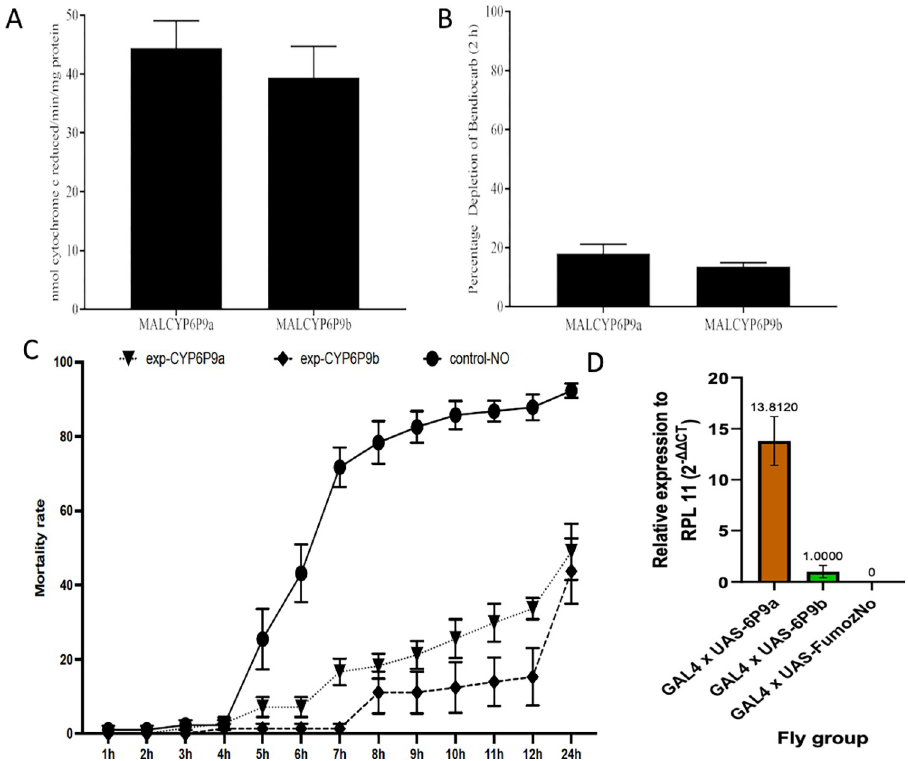
Fig 3. Functional validation of the ability of CYP6P9a/b to confer resistance to carbamates. A) Determination of cytochrome P450 reductase activity using a model substrate, cytochrome c . All results are average of three replicates ± standard error of the means. B) Metabolic activities of the recombinant An . funestus CYP6P9a and CYP6P9b . Depletion of 20 μ M bendiocarb in metabolic assays with recombinant CYP6P9a and–b (SEM = 3). C) Transgenic expression of CYP6P9a/b in Drosophila melanogaster using the GAL4/UAS system. The observed mortality pattern of GAL4 x UAS-CYP6P9a and GAL4 x UAS-CYP6P9b flies exposed to 0.007% bendiocarb. D) The relative expression of the CYP6P9a and b transgenes in transgenic D . melanogaster Act5C-CYP6P9a/b strains and the control sample with no transgene expression. The data shown are the mean ± SEM (n =